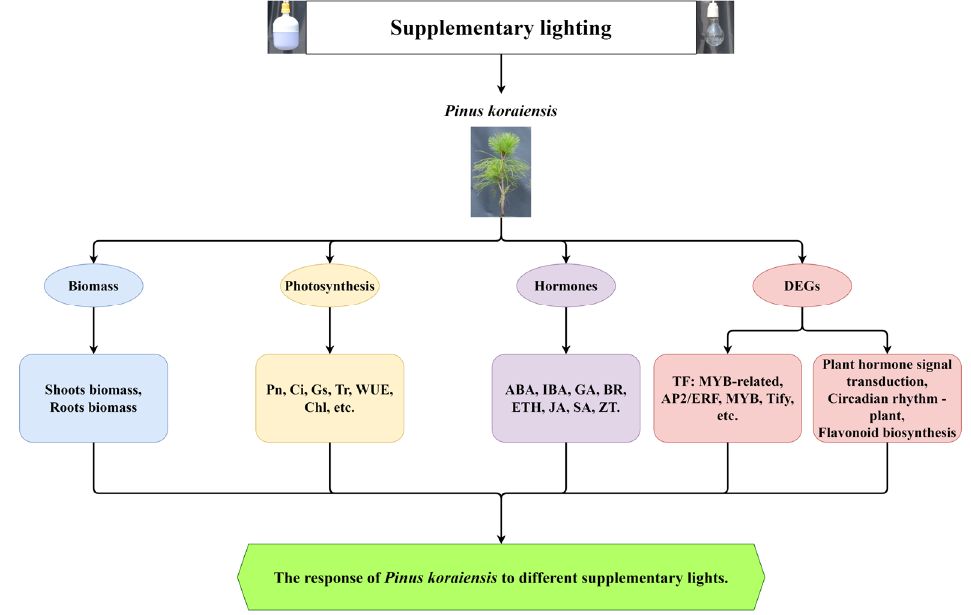
Figure 12. A proposed model of the response of P. koraiensis under different supplementary lighting. The model suggested that the biomass, photosynthetic parameters, hormones, TFs, and several metabolic pathways were altered under different supplementary treatments. They all played a role in the response to supplemental lighting.